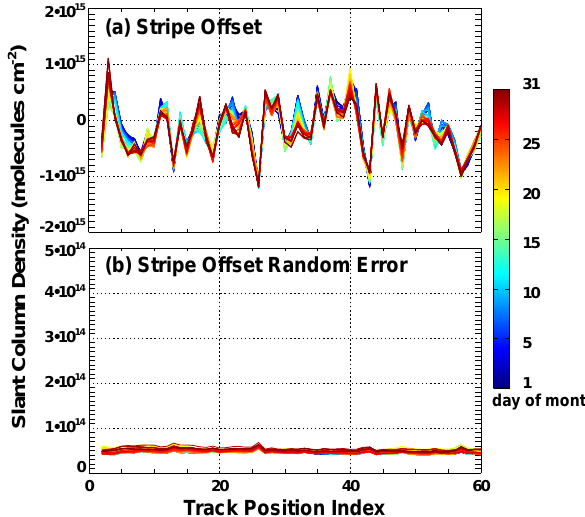
Figure 7. (a) Stripe offset (moleculescm − 2 ) derived from a run- ning 5-day mean of the slant columns retrieved over the Sahara (20–30 ◦ N, 10 ◦ W–30 ◦ E) for July 2006 as a function of cross-track position. Lines are colour coded by day of the month. (b) Estimate of random SCD error (moleculescm − 2 ) for (a) induced from noise in the measured